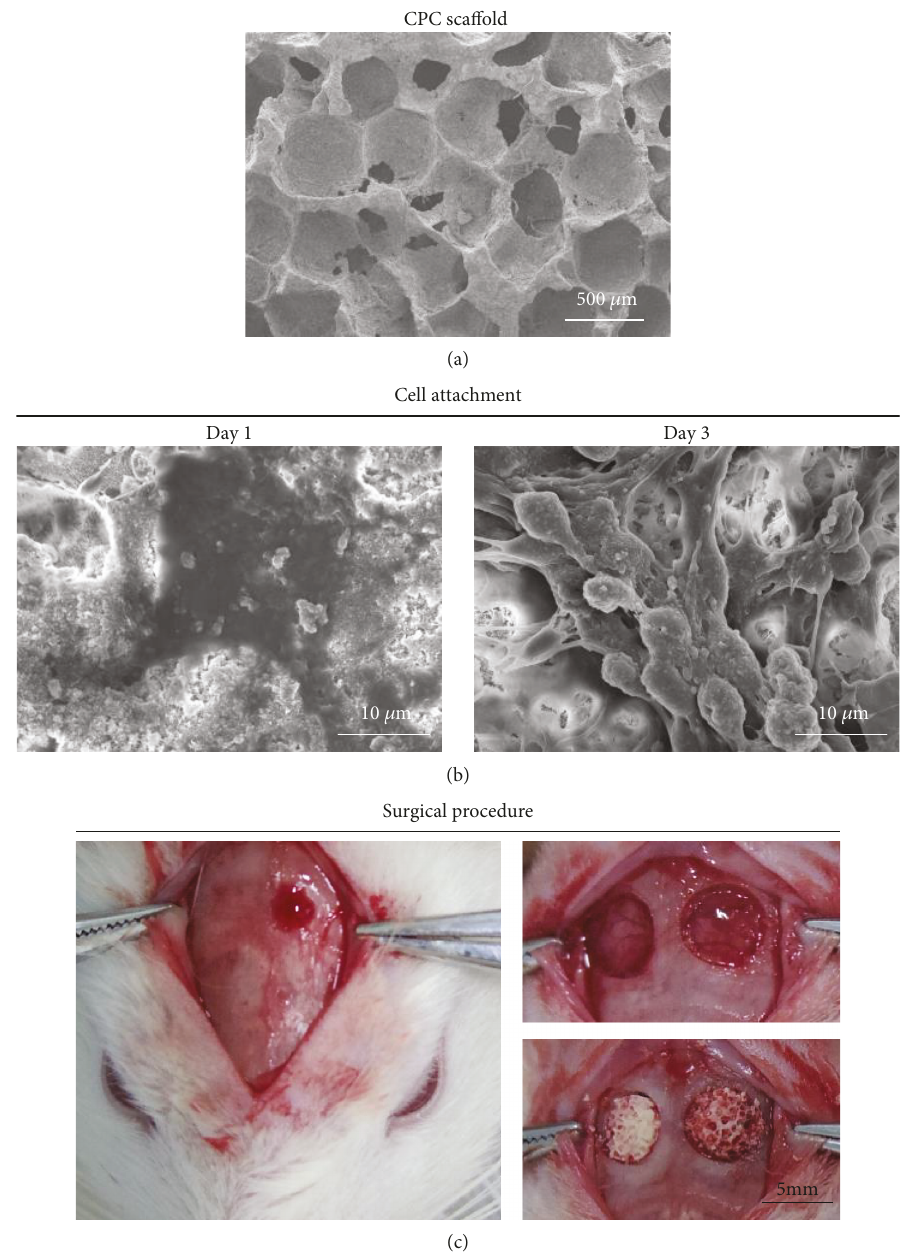
Figure 5: SEM analysis and surgical procedure. (a) SEM evaluation of porous CPC sca ff old showing an average pore diameter of 300 – 500 μ m. (b) BMSCs attached and spread well on CPC sca ff olds. (c) Surgical procedure. CPC: calcium phosphate